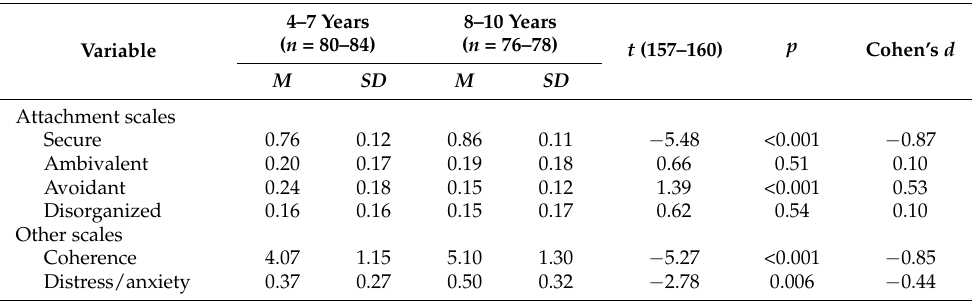
Table 4. Means, Standard Deviations, and t -test Statistics for the Scales comparing Younger and Older Children in Middle Childhood.